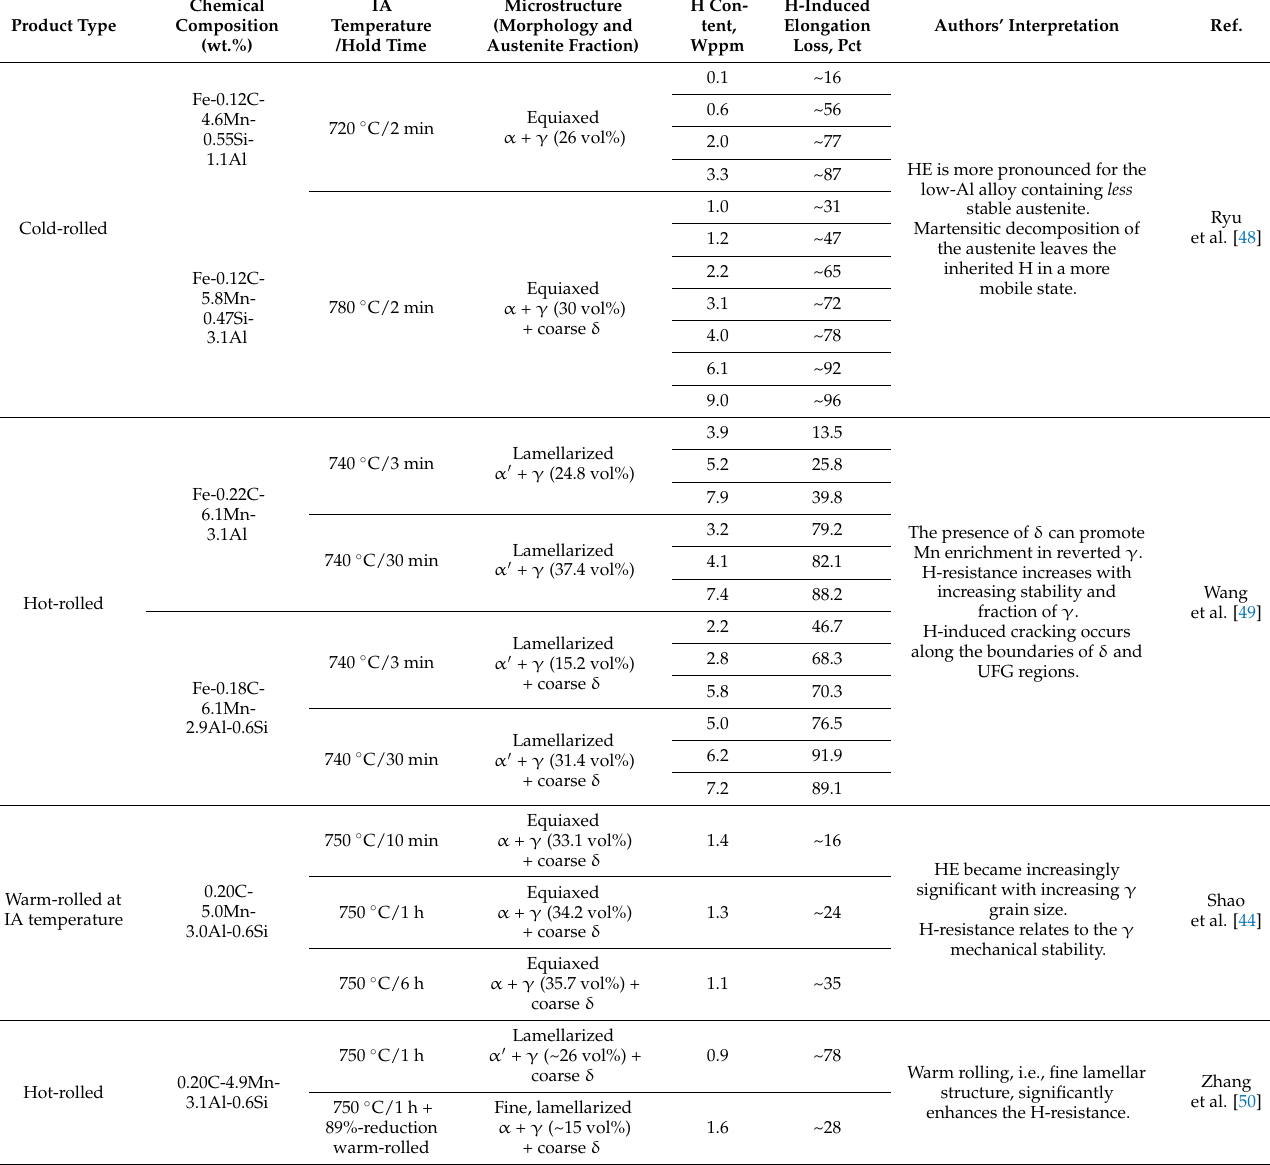
Table 2. HE characteristics of Al– and Si–alloyed medium-Mn steels, evaluated by means of SSRT testing at room temperature ( α , α –ferrite; α (cid:48) , α (cid:48) –martensite; γ , austenite; and δ , δ –ferrite). Product